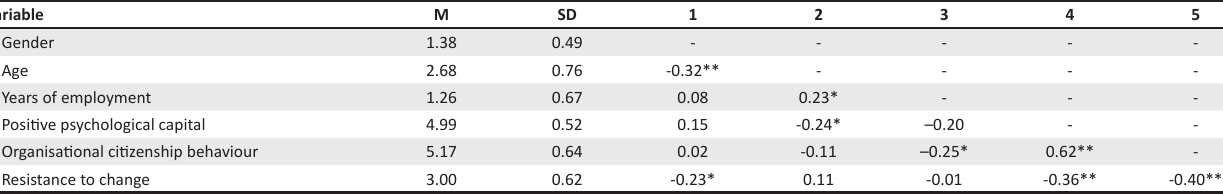
TABLE 2: Intercorrelations between study variables ( N = 97). Variable